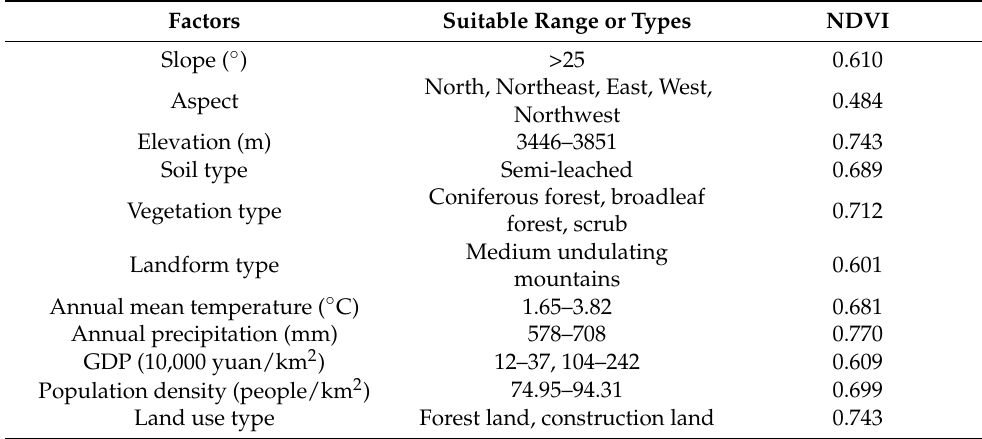
Table 8. Suitable range or types of natural